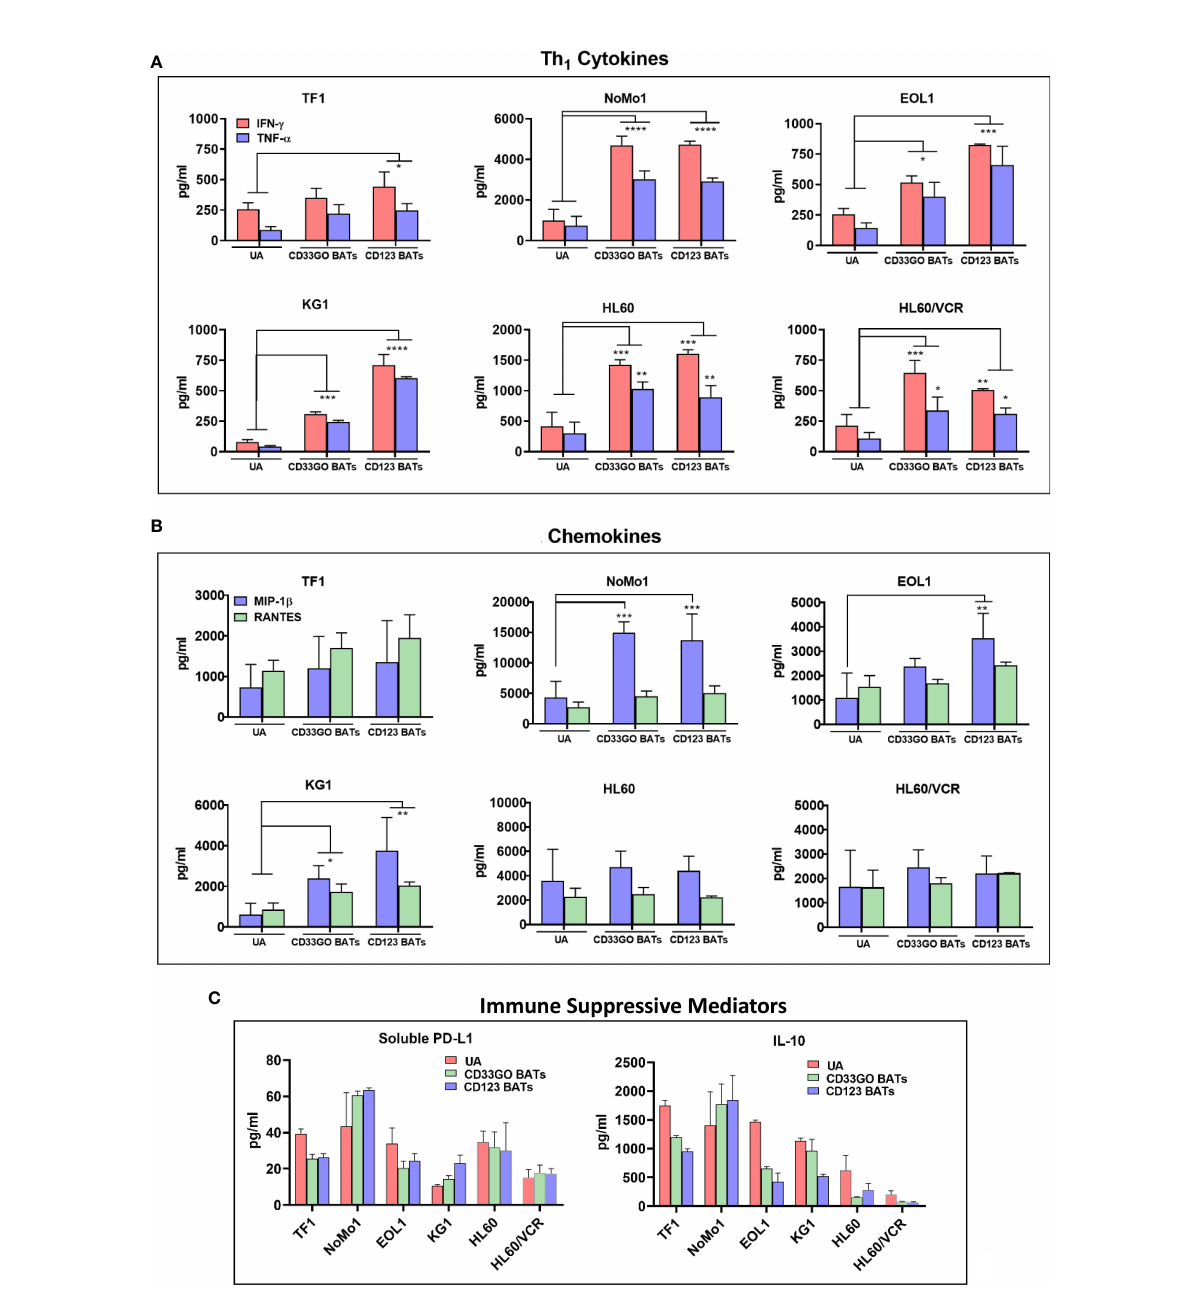
FIGURE 3 Cytokines/Chemokines Production upon BATs Engagement of AML cells. Cell-free supernatants were collected after 18 hr co-cultures of TF1, NoMo1, EOL1, KG1, HL60 and HL60/VCR cell lines with unarmed ATC, CD33GO- or CD123 BATs at E:T of 10:1 (n=3) for cytokine/chemokine pro fi ling using 3 normal donor ATC or BATs. (A) Mean ± SD for IFN- g and TNF- a are shown for all six cell lines, background levels were subtracted using non-AML DAUDI cell line. Wilcoxon signed-rank test showed statistically signi fi cant difference in cytokines and chemokines produced in the culture supernatants of CD123 BATs plus AML cells or CD33GO BAT plus AML cells compared to the culture supernatants of unarmed ATC (UA) plus AML cells for IFN- g and TNF- a for most cell lines (p value ranged from p<0.05 - p<0.00005). (B) Shows the chemokines MIP1-b and RANTES (pg/ml), background levels were subtracted using non-AML DAUDI cell line. Statistical analysis was performed using Wilcoxon signed-rank test. Chemokine MIP1-b was signi fi cantly higher (p value ranged from p<0.05 - p<0.0005) in the culture supernatants of CD123 BATs+AML cells and CD33GO BATs+AML cells compared to unarmed ATC (UA)+AML cells for NoMo1, EOL1 and KG1; RANTES showed signi fi cantly higher levels only in the culture supernatants of CD123 BATs+KG1 cells and CD33GO BATs+KG1 cells. (C) Shows the levels of immune suppressive sPD-L1 and IL-10 in the culture supernatants of CD123 BATs+AML cells, CD33GO BATs+AML cells and unarmed ATC (UA)+AML cells for all 6 cell lines. (* = p<0.05; ** = p<0.005; *** = p<0.0005; **** =